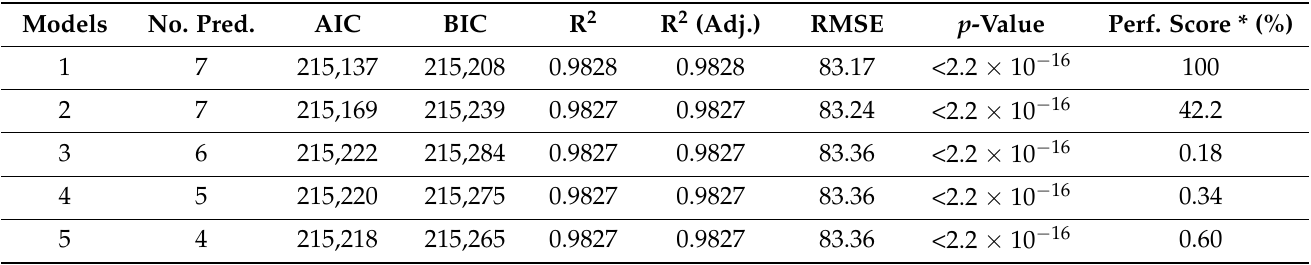
Table 2. Statistic parameters for all-seasons selected